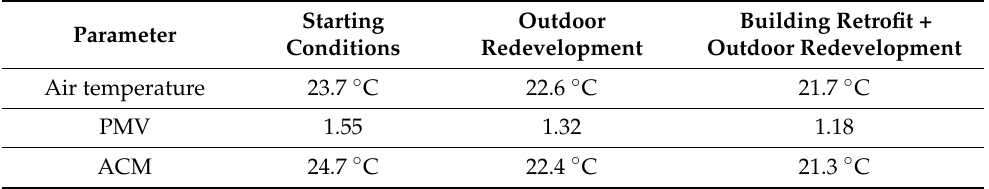
Figure 16. The indoor output of air temperatures and PMV considering only outdoor climate adaptive redevelopment: ( a ) The simulated flat for the Materdei building; ( b ) The simulated flat for the Ponticelli building. Table 15. Comparison of air temperature, PMV, and ACM output data for the Materdei apartment under initial conditions and after the combination of indoor and outdoor strategies.